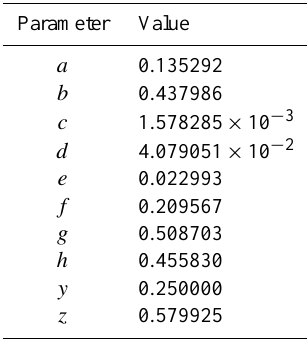
Table 3. List of parameters.